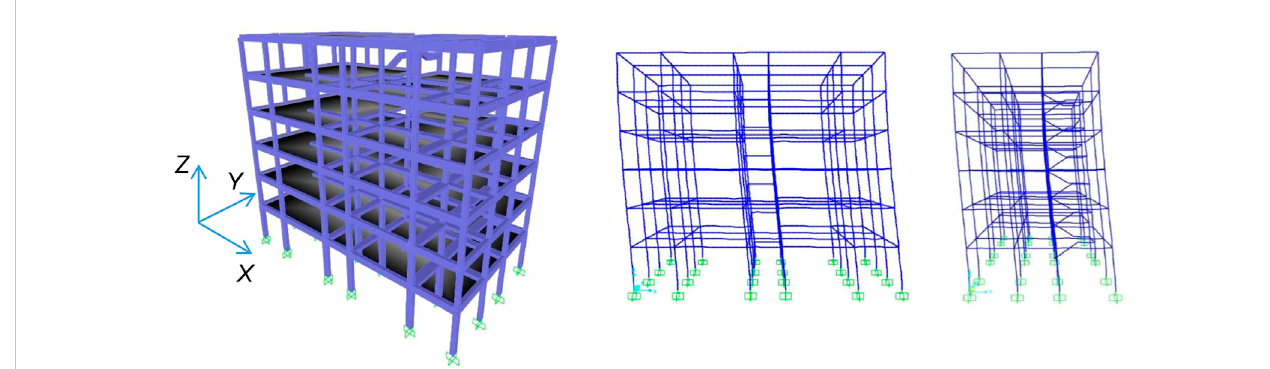
FIGURE 4 Views of the fi nite element model of the structure and the fi rst mode shapes in X and Y .